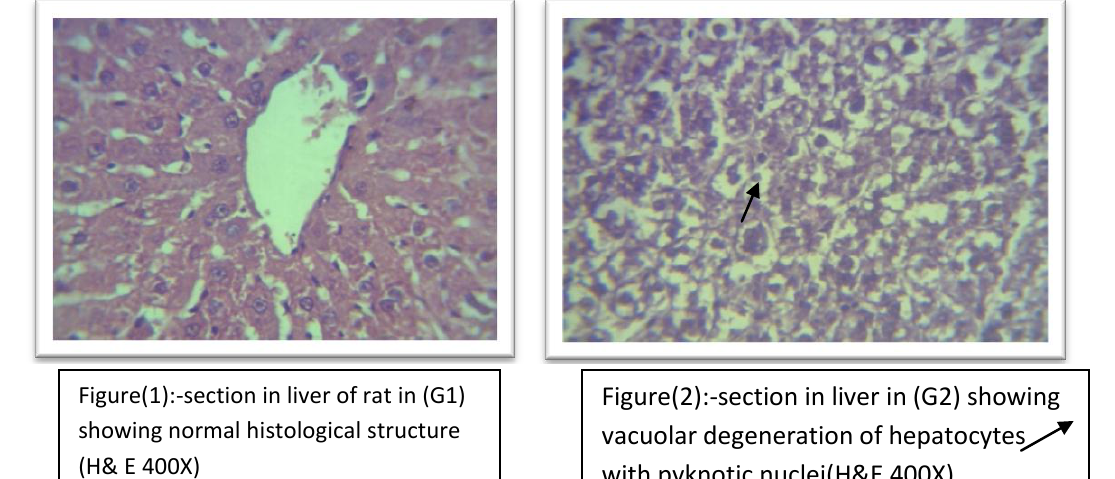
Figure(2):-section in liver in (G2) showing vacuolar degeneration of hepatocytes with pyknotic nuclei(H&E 400X)